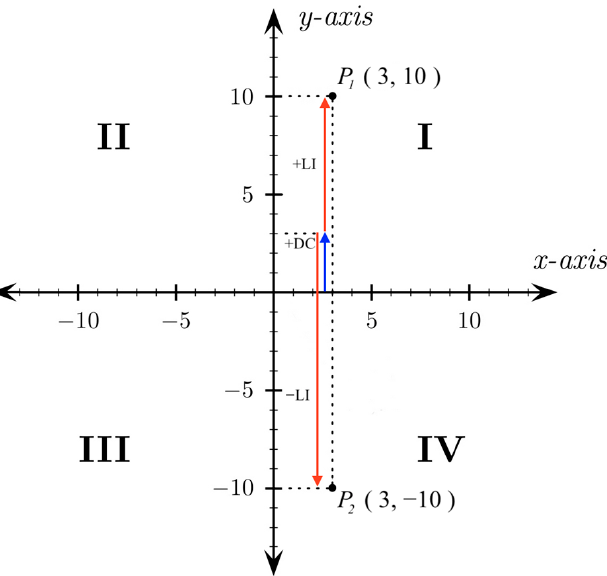
Figure 11. Four-quadrants diagram for assessment of breakdown voltage (U BD ) under composite voltage.